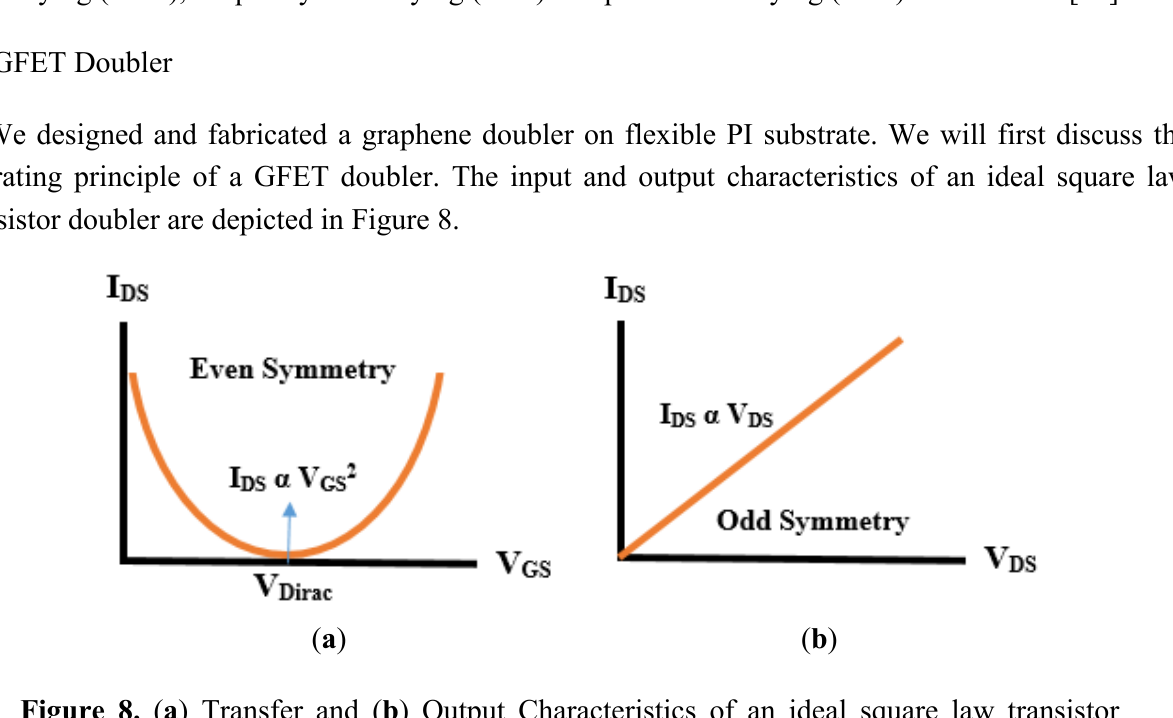
Figure 8. ( a ) Transfer and ( b ) Output Characteristics of an ideal square law transistor doubler (adapted from [22], Copyright 2011, AIP Publishing